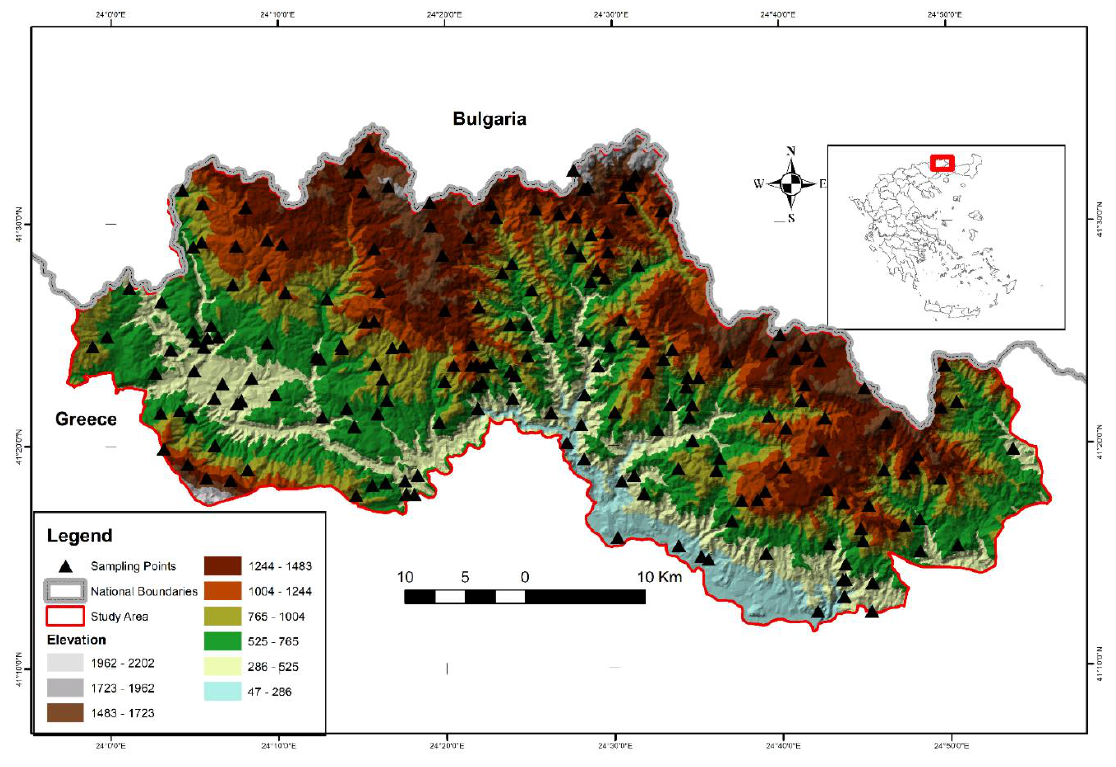
Figure 1. Location of the study area and landscape and oreographic characteristics.